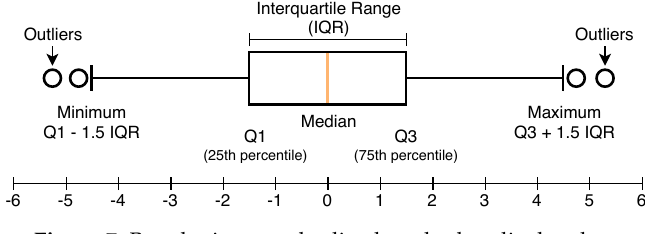
Figure 7. Boxplot is a standardized method to display